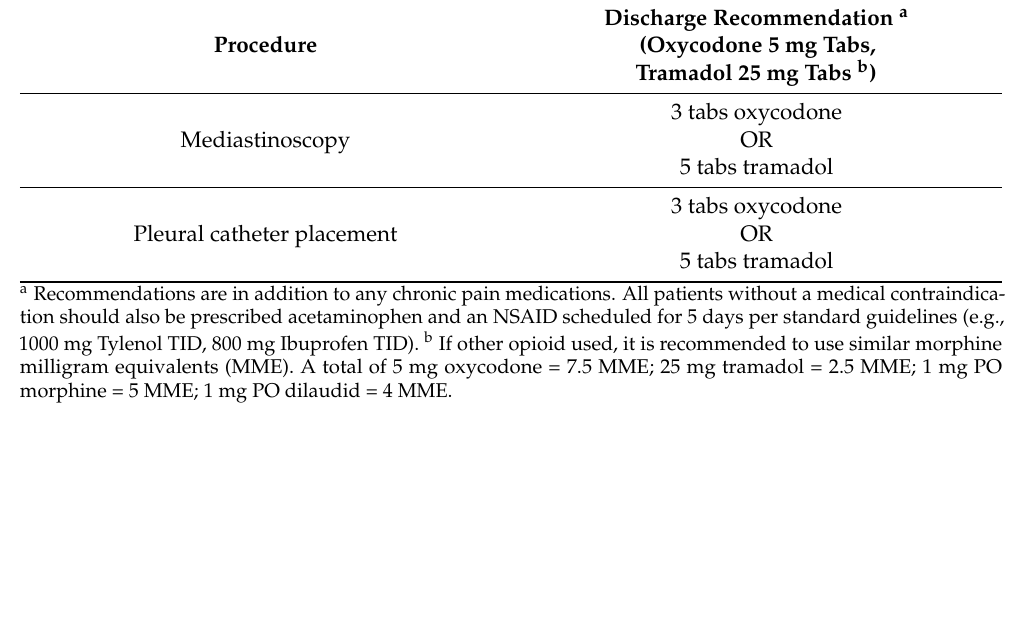
Table A3. VAPHS Opioid Prescribing Outpatient/Observation Guidelines: Thoracic